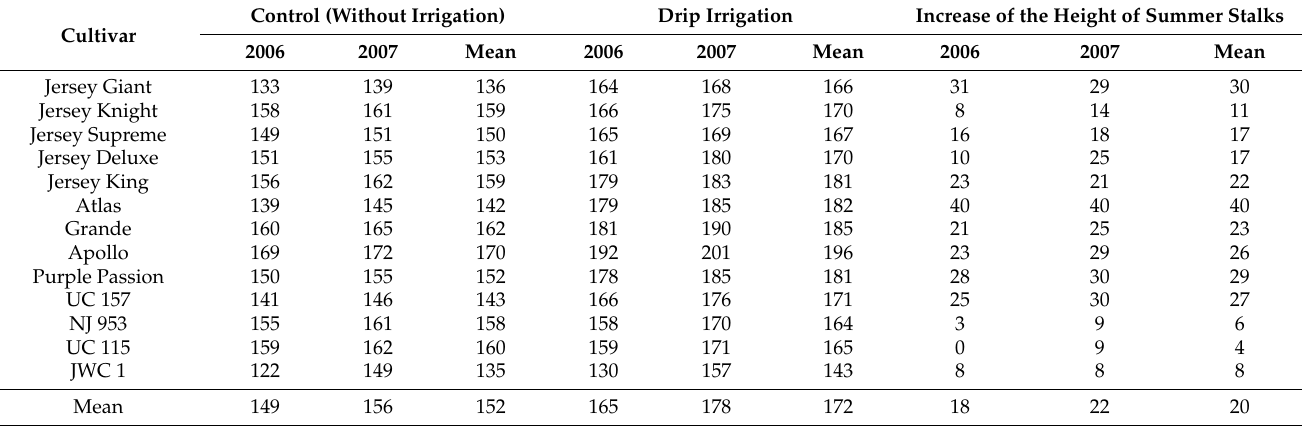
Table 7. Height of the asparagus summer stalks (cm) as dependent on cultivar and irrigation.